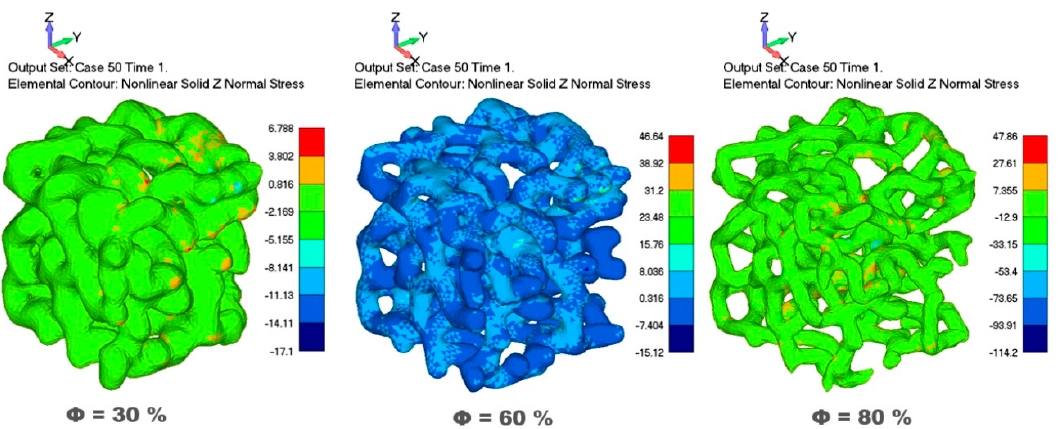
Figure 3. Von Mises stress contours in the test direction for three different porosities under uniaxial uniformly applied load.